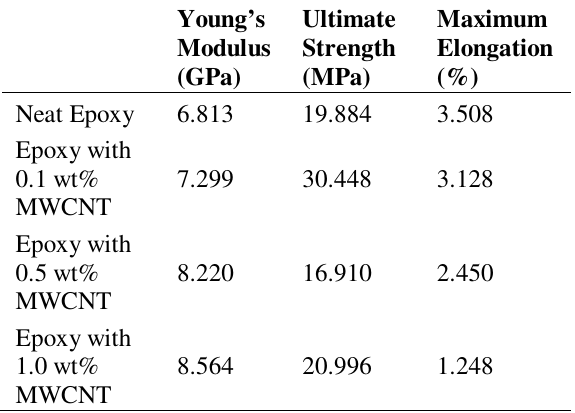
Mechanical Property of Epoxy /MWCNT Nanocomposites.